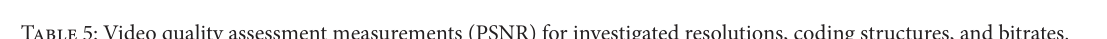
Table 5: Video quality assessment measurements (PSNR) for investigated resolutions, coding structures, and bitrates. No. of B-frames